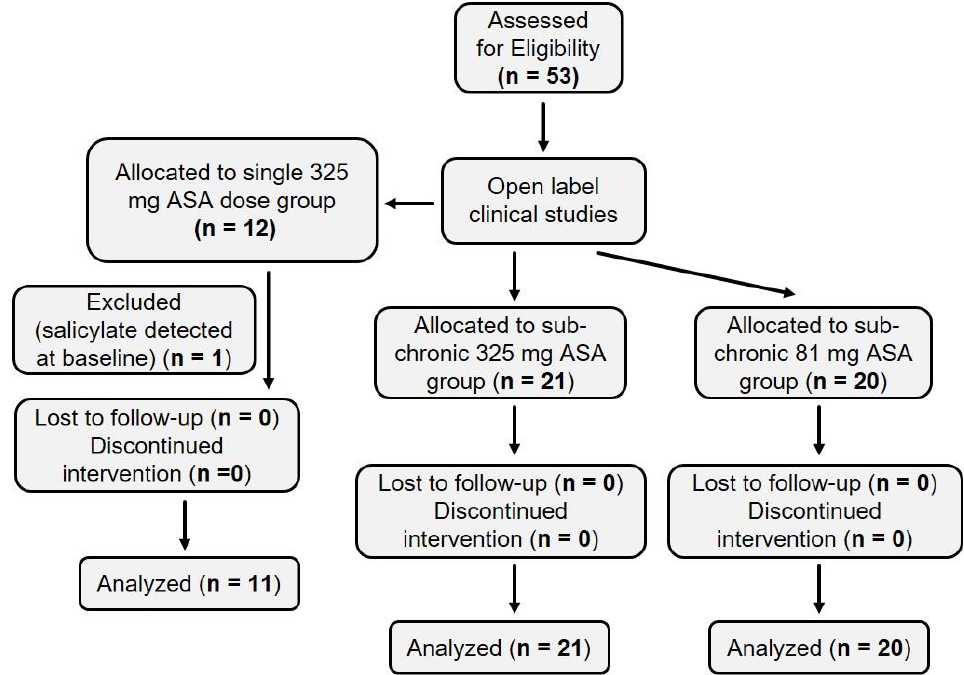
Figure 1 . CONSORT flowchart. A total of 53 subjects were eligible and enrolled. Twelve subjects were enrolled in the single 325 mg acetylsalicylic acid (ASA) cohort, and one subject was excluded because salicylate was detected in the baseline (pre-ASA) plasma sample. Twenty-one and 20 subjects were enrolled in the sub-chronic 325 mg and 81 mg ASA cohorts, respectively. All data from these 41 subjects were analyzed.